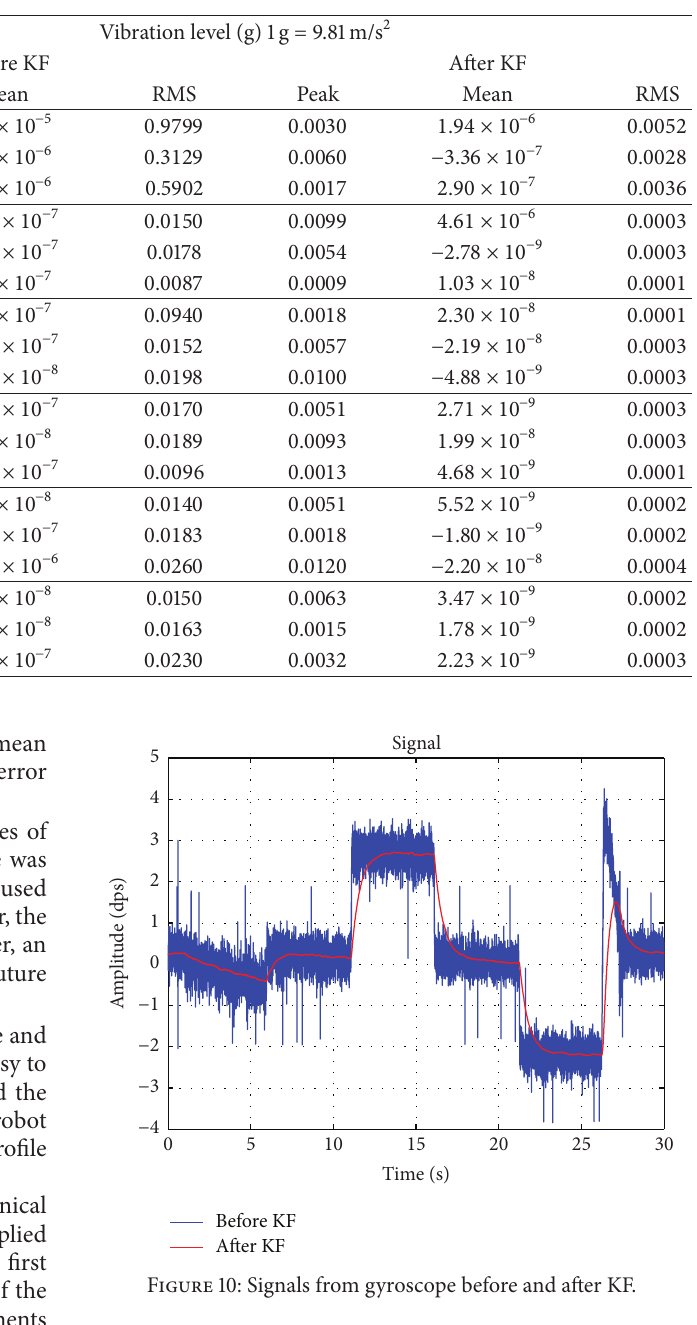
Table 5: Analysis of the vibration parameters on each robot link.